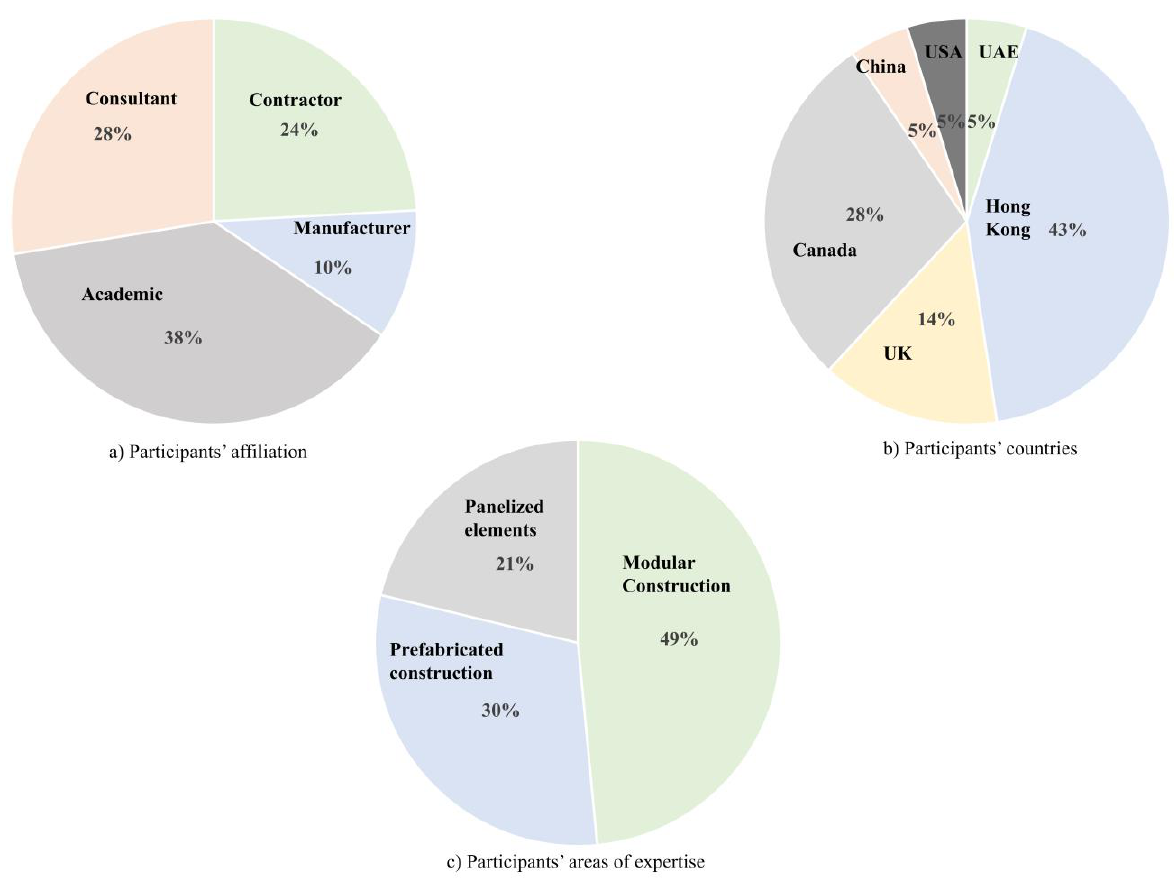
Figure 8. Information of the participants: ( a ) participants’ affiliations, ( b ) participants’ countries, and ( c ) participants' areas of expertise .